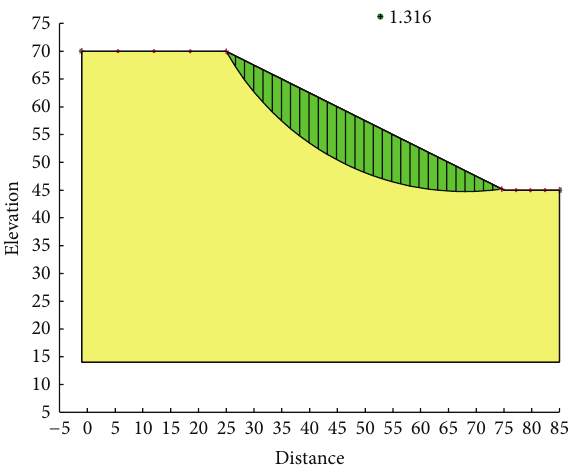
Figure 11: Critical failure surface with the Spencer method.